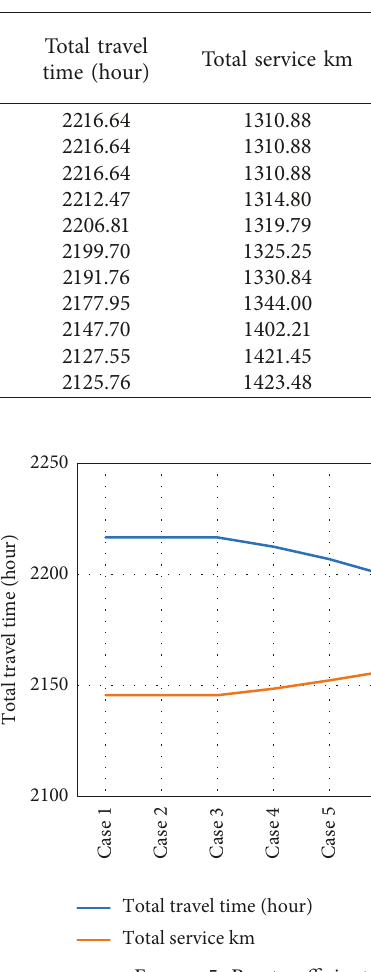
Table 2: Computational results for the proposed model without departure offsets.